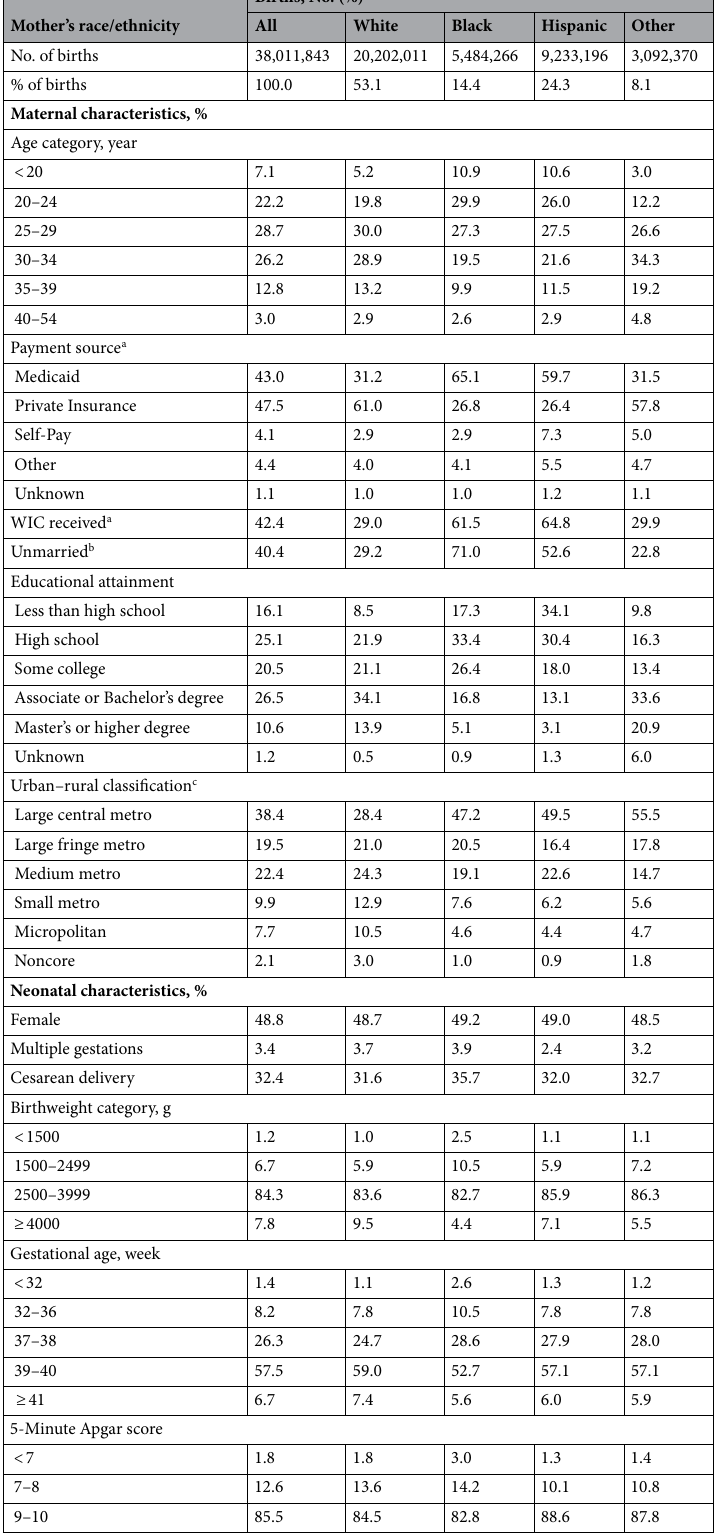
Table 1. Maternal and neonatal characteristics of live births: United States, 2008–2018. a Information was restricted to births since 2009 when they started to be collected. b Births occurring in or to residents of California in 2017–2018 were excluded due to state statutory restrictions. c The National Center for Health Statistics’ (NCHS) Urban–Rural Classification Scheme for Counties was